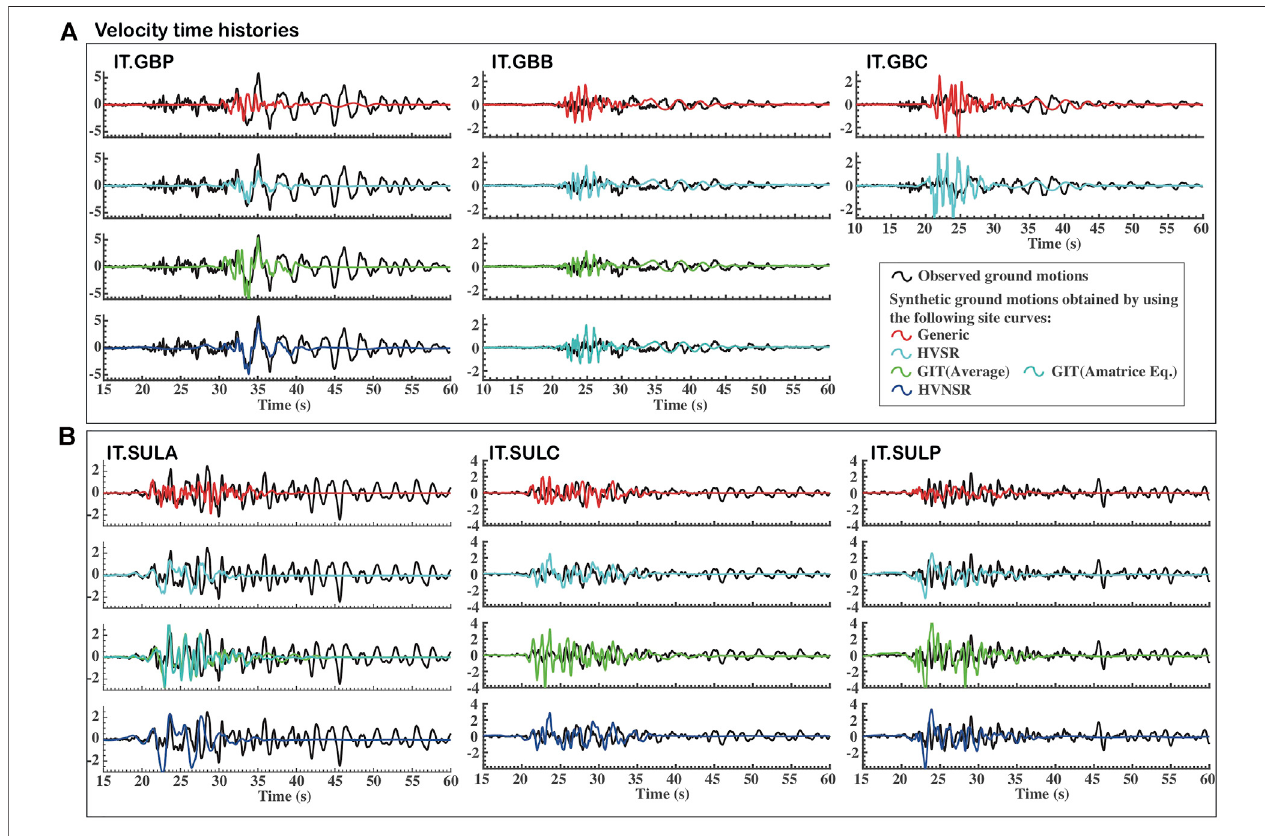
FIGURE4| VelocitytimeseriesatGubbio[panel (A) ] and Sulmona [panel (B) ]sites. In black, weplotrecordedseismograms(arithmetic mean ofthe twohorizontal components). Colored lines depict synthetic hybrid seismograms obtained from the HF and LF contributions (see Section 2.3 ), obtained through the EXSIM code seismic source inversion by Tinti et al. (2016). They were obtained by using empirical site curves in the EXSIM code: GIT (green), HVSR (cyan), and HVNSR (blue).